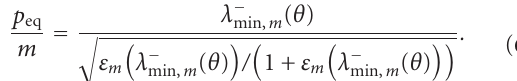
Figure 7: Sketch of (a) the original array of slits and (b) the corresponding equivalent structure with orthogonal excitation. SPP modes are also reported on the proper metal-dielectric